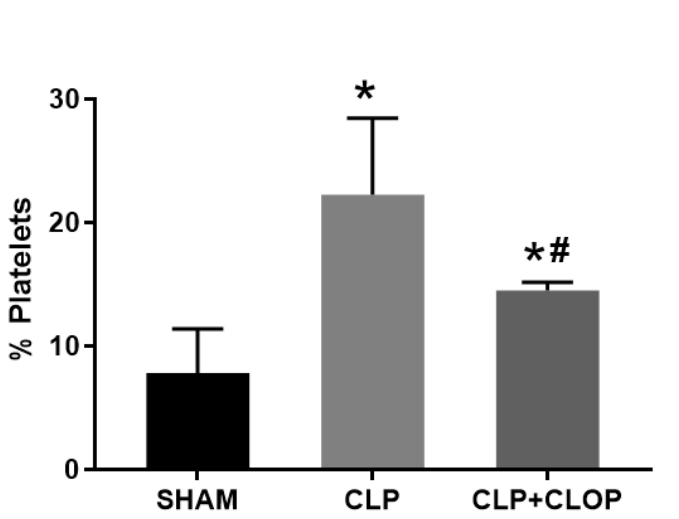
Figure 1. Platelet Activation. Platelet activation was measured by flow cytometry. Platelets were isolated form Sham, Cecal ligation and puncture (CLP) and CLP + Clopidogrel (CLP + CLOP). Activated platelets were identified as CD41 + /CD62P + . * p < 0.05 vs. Sham; # p > 0.05 vs. CLP.